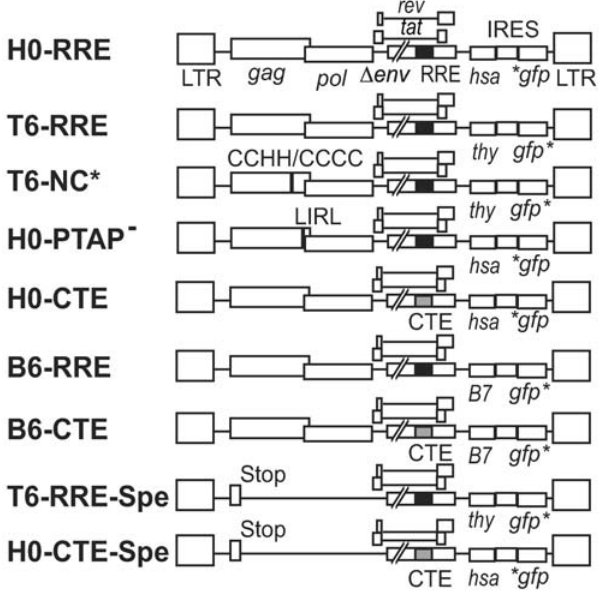
Figure 1. General structures of the viruses used in the recombination and packaging assays. H0-RRE is shown on top and elements of other viruses different from H0-RRE are labelled. Two marker genes are located in nef of each virus; the translation of the gfp gene was directed by IRES. The inactivating mutations in gfp are shown as asterisks. Black box represents the HIV-1 RRE, whereas gray box represents four copies of MPMV CTE.